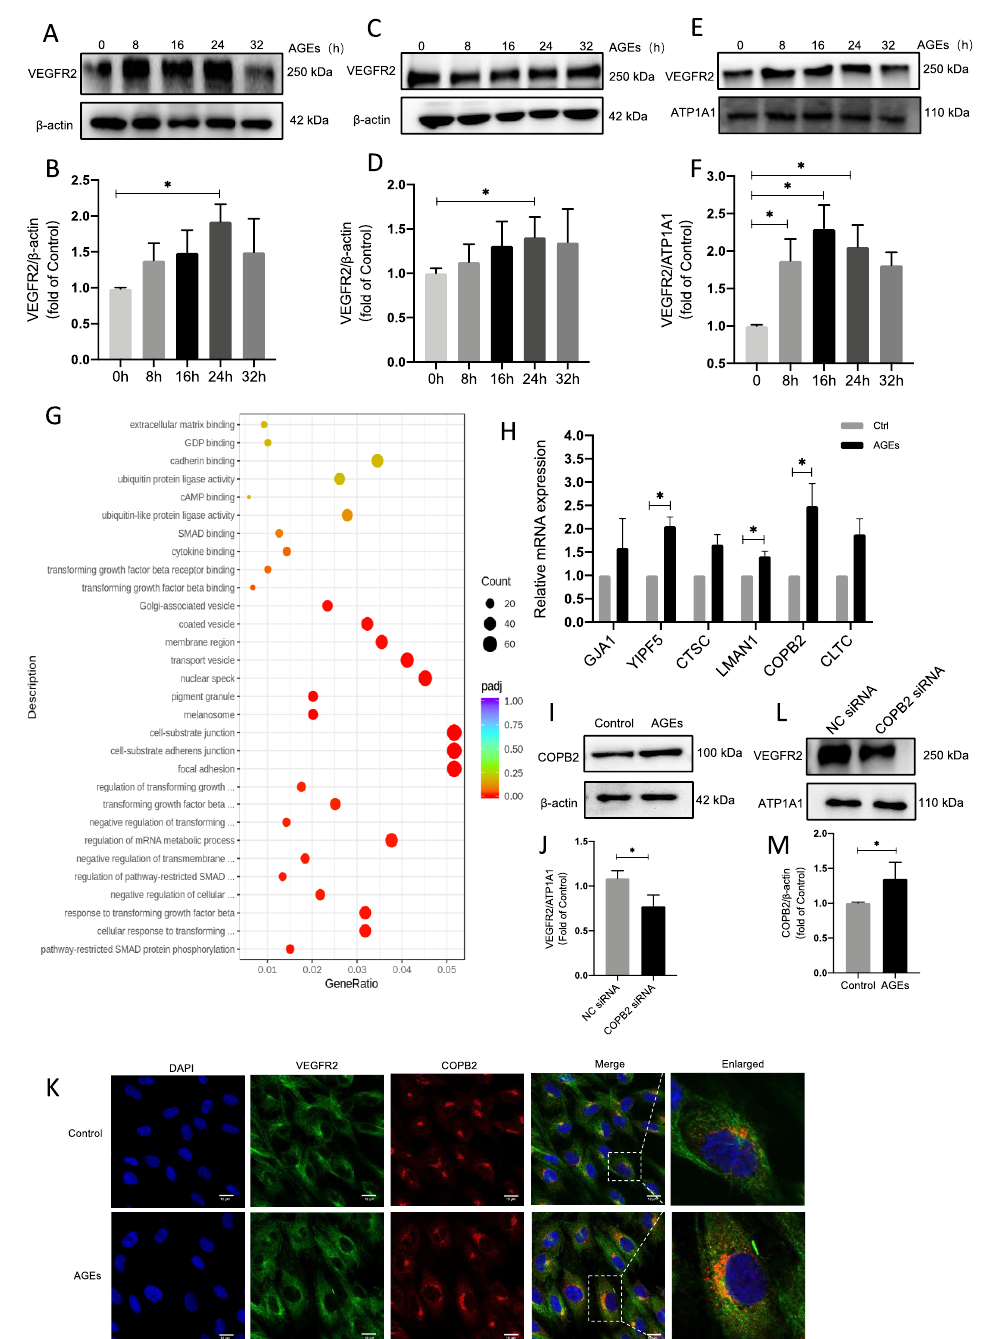
Figure 5. COPB2 mediates enhanced transport of VEGFR2 to membranes. ( A , B ) AGEs induce total VEGFR2 protein expression in endothelial cells. 100 µ g/mL AGEs were applied to HUVECs stimulated for 0, 8, 16, 24, and 32 h, n = 6, * p < 0.05 vs. 0 h. ( C – F ) Endothelial cell cytoplasm cytosol was isolated and extracted with the kit. 100 µ g/mL AGEs were applied to HUVECs stimulated for 0, 8, 16, 24, and 32 h VEGFR2 protein expression for cytoplasmic protein ( C ), cytosolic protein ( E ), n = 6, * p < 0.05 vs. 0 h. ( G ) Bubble plot GO enriched to upregulate the expression of proteins associated with Golgi transport. ( H ) qPCR detection of mRNA levels of the first few vesicles transport-related proteins, n = 4, * p < 0.05 vs. 0 h. ( I , J ) AGEs stimulation followed by detection of COPB2 protein expression levels in VEGFR2 expression, n = 7, * p < 0.05 vs. 0 h. ( K , L ) Immunofluorescence detection of COPB2 fluorescence intensity, DAPI (blue), VEGFR2 (green), and COPB2 (red). ( M ) Transfection of COPB2 siRNA to detect cell membrane VEGFR2 expression levels. * indicates significance between the indicated